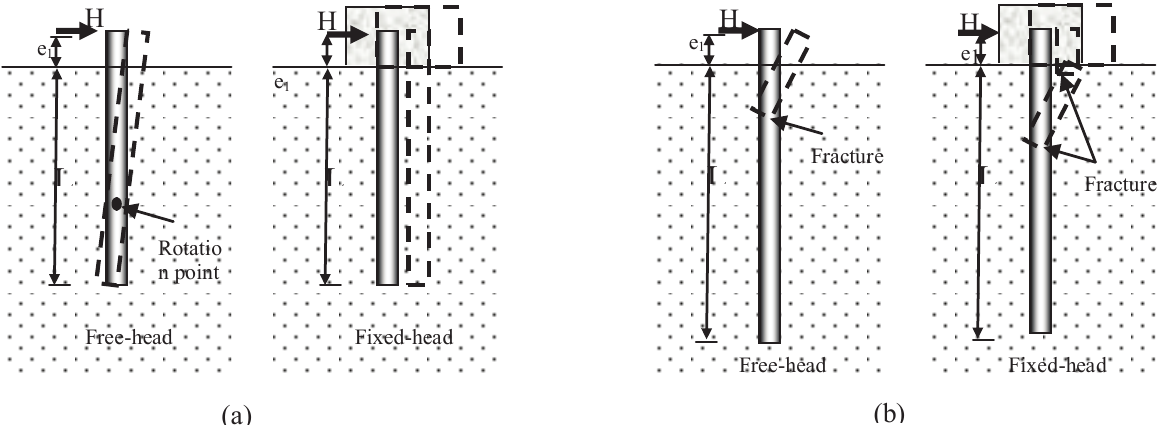
Figure 1. Failure modes of vertical pile under lateral load (Broms, 1964a&b): (a) short pile under lateral load and (b) long pile under lateral load